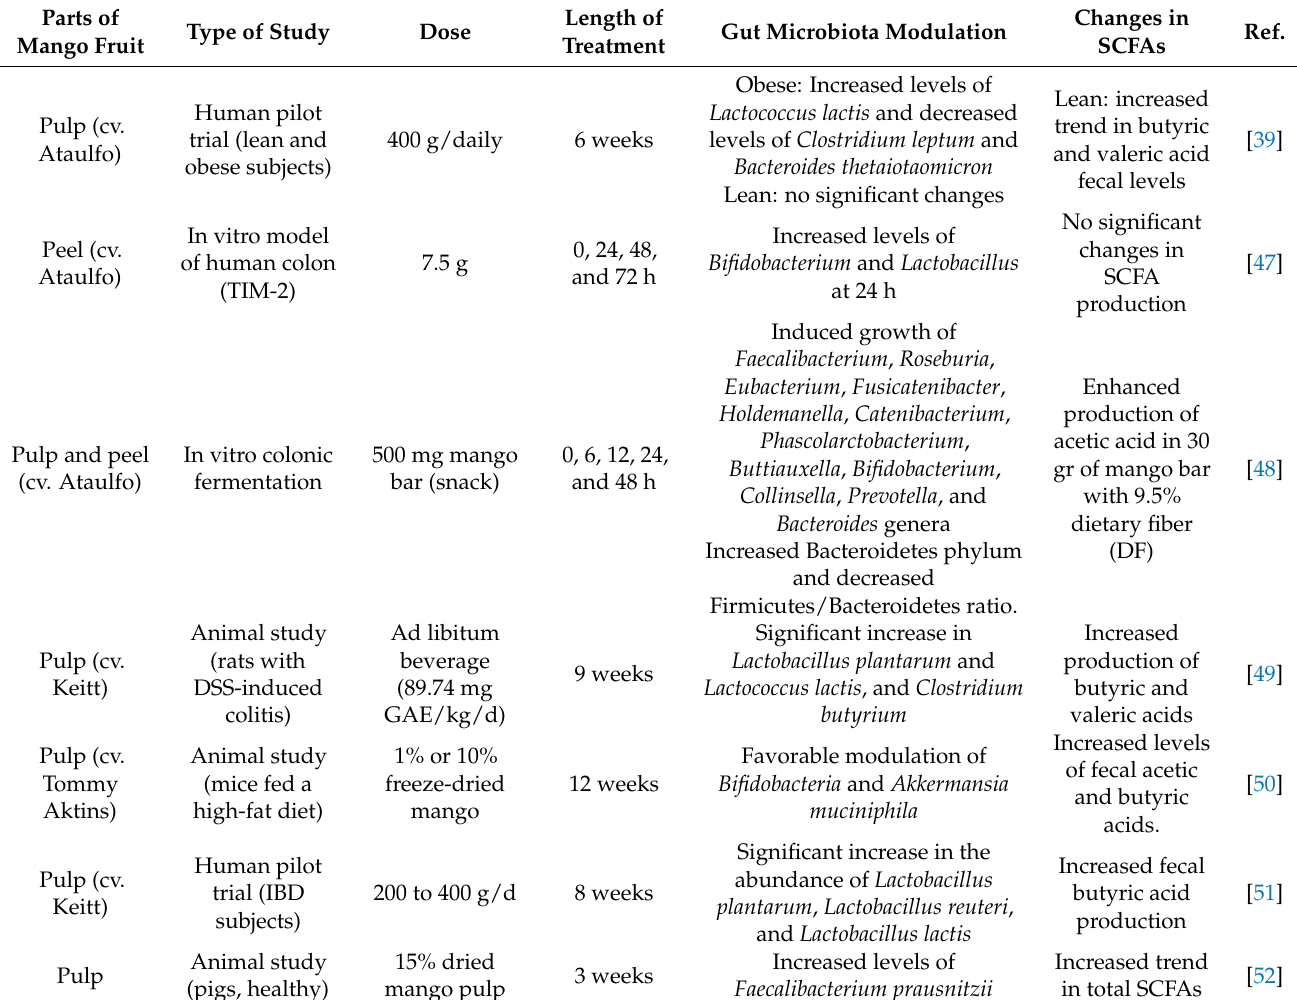
Table 1. Gut microbiota modulation by mango polyphenols, summarizing changes in short chain fatty acids (SCFA). Parts of Mango